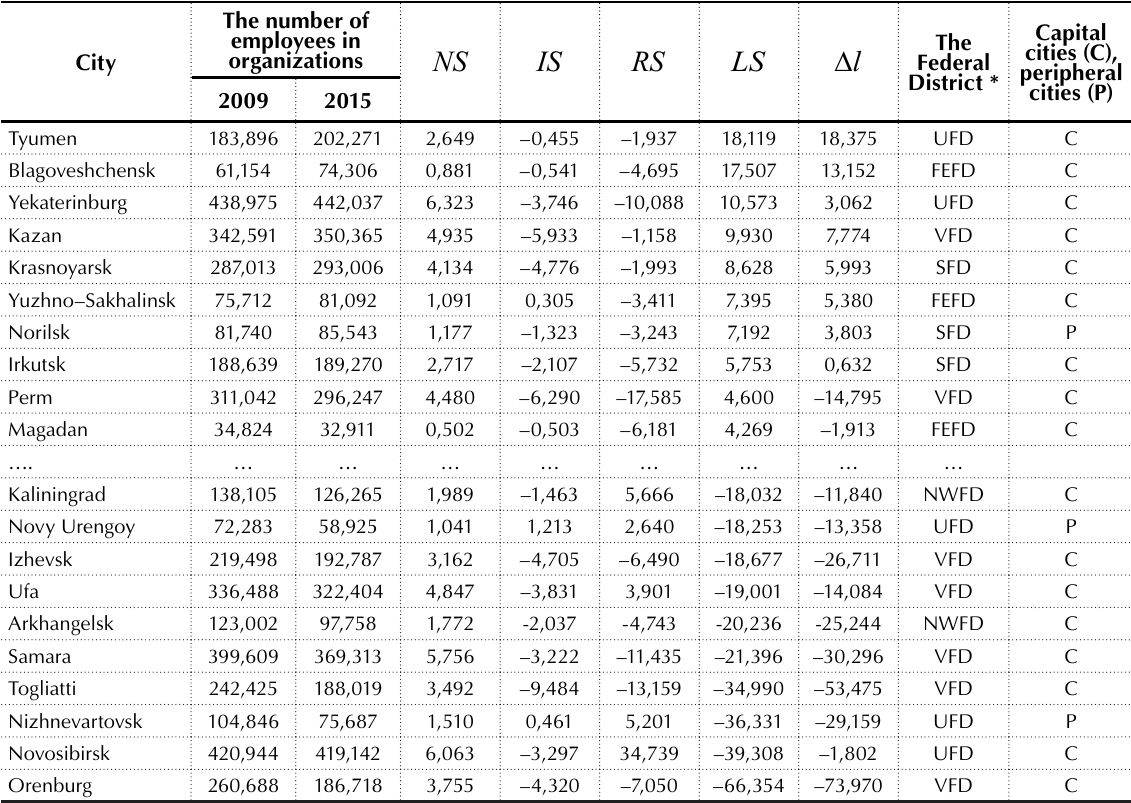
Table 9. The calculation of structural shifts in employment in Russian cities, 2009–2015, thousand people